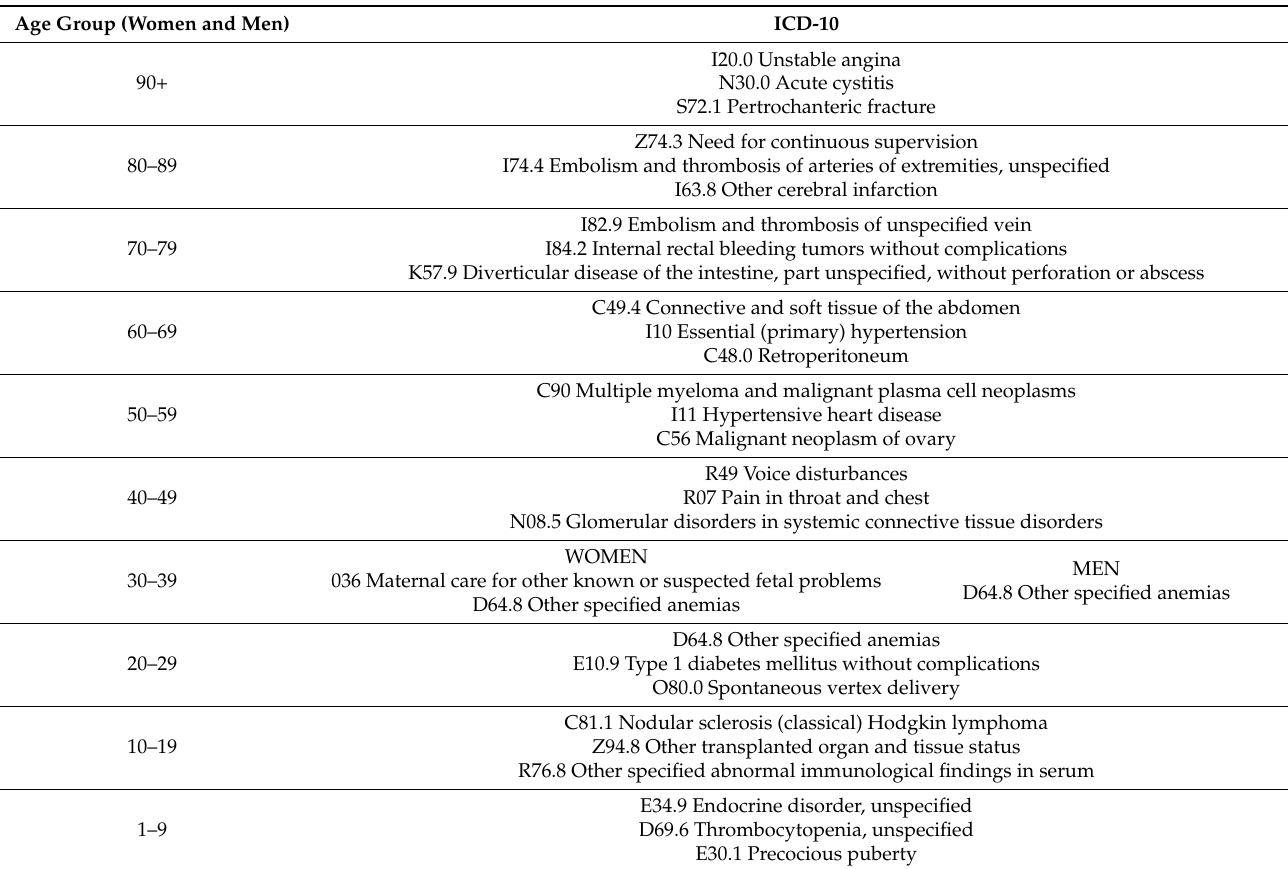
Table 4. Recognitions among age groups—the most common.